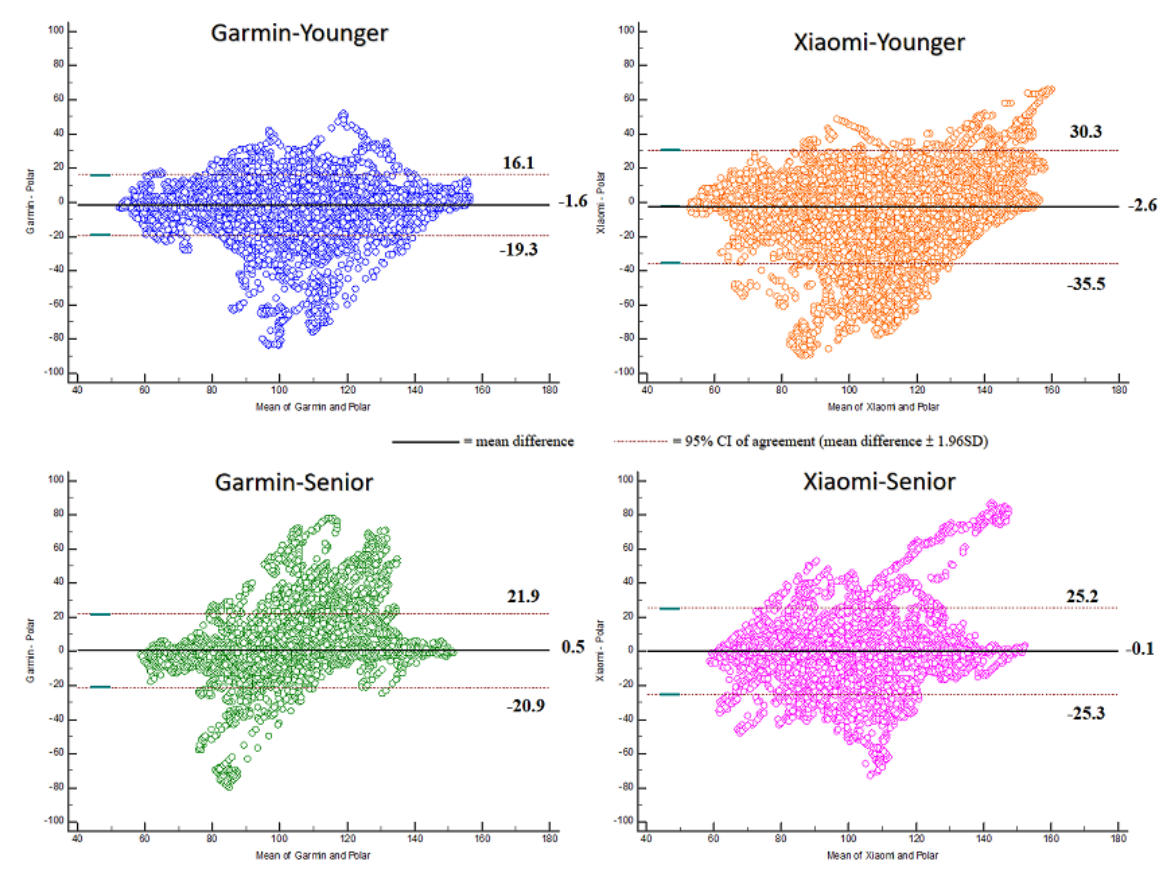
Figure 3. Bland-Altman plots of overall phases for different age groups and